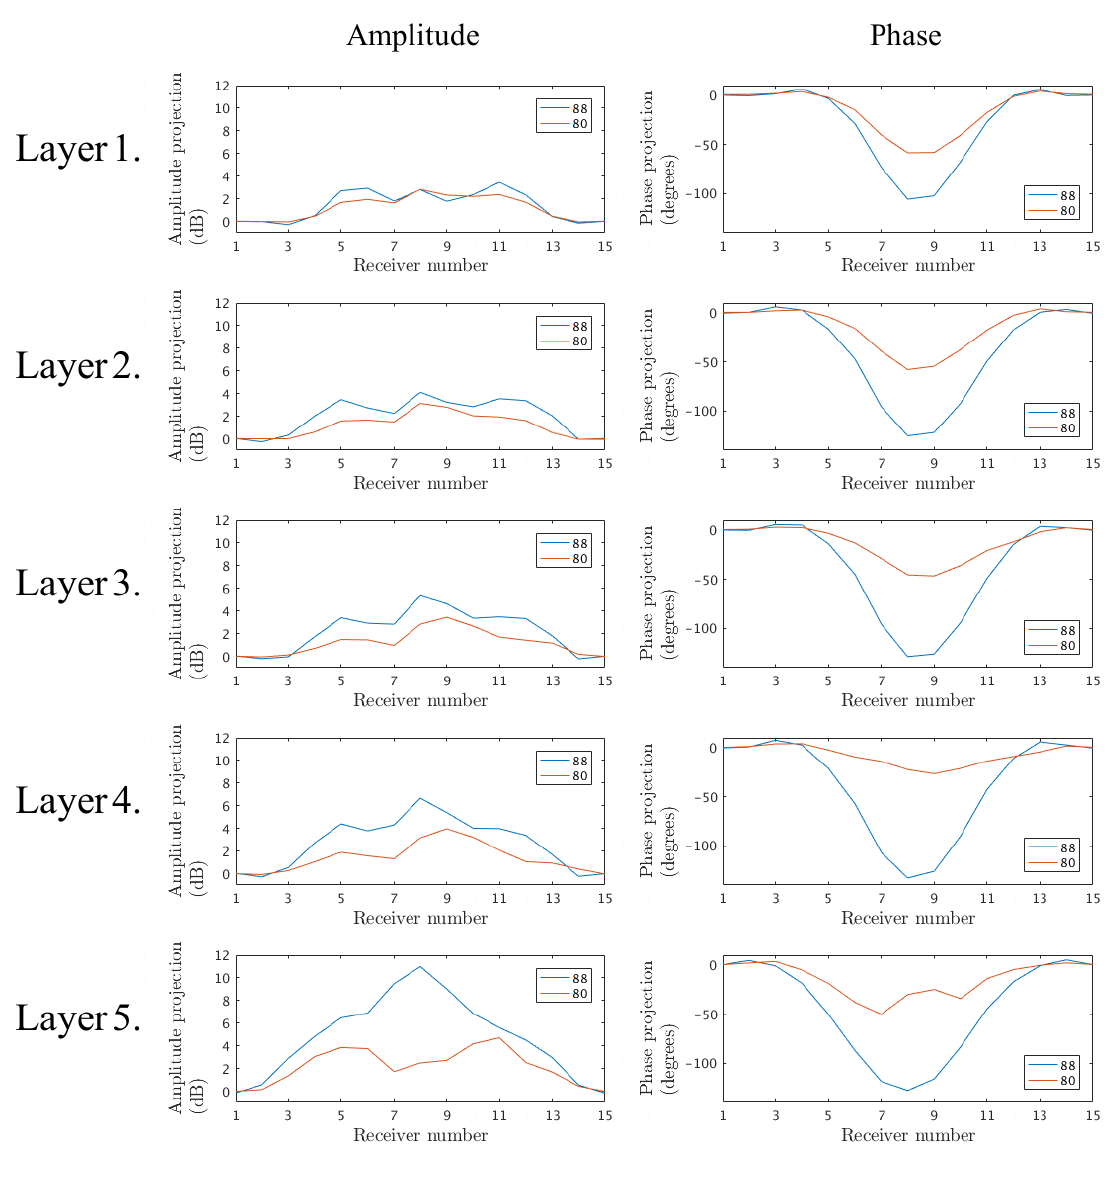
Figure 8. Projection data of the signals transmitted from Antenna 1 at 1500MHz for the five interrogated layers. Measurements of the outer shell filled with the 88:12 and 80:20 glycerin–water mixtures,